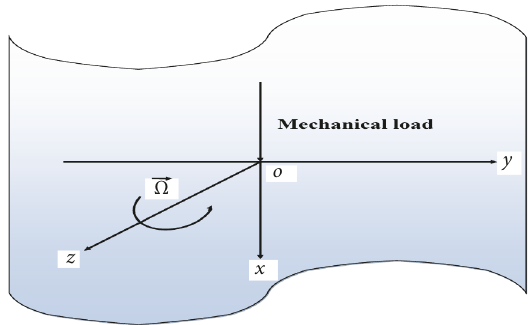
Figure 1: Mechanical load over a functionally graded rotating magneto-thermoelastic medium.